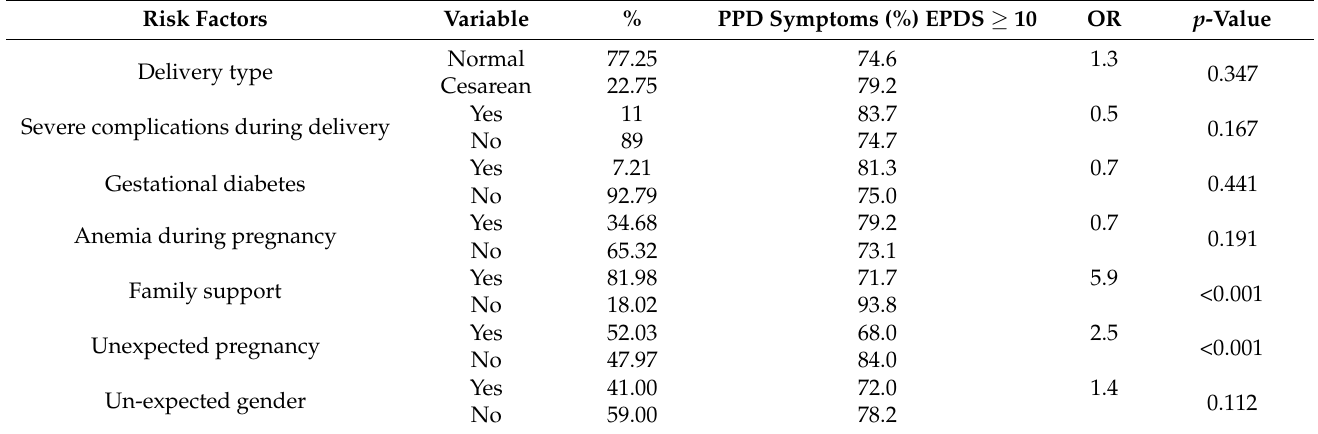
Table 3. Logistic regression model for factors associated with the PPD.